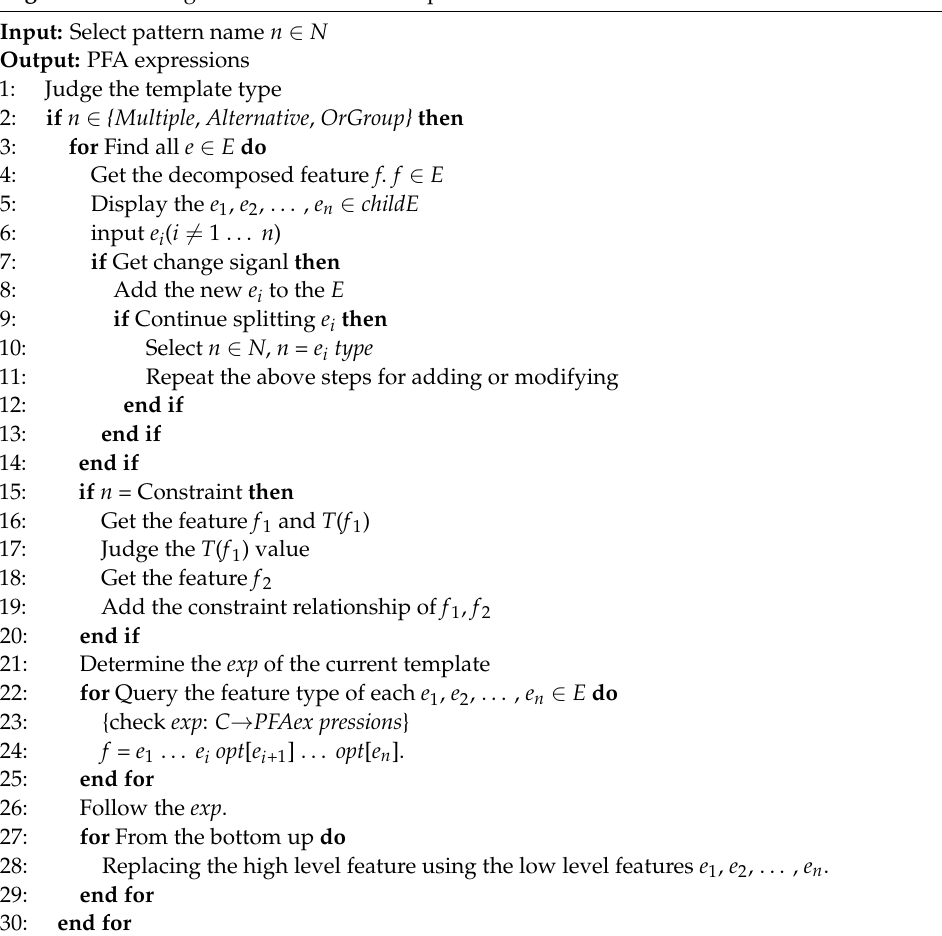
Algorithm 1: PFA generation based on templates